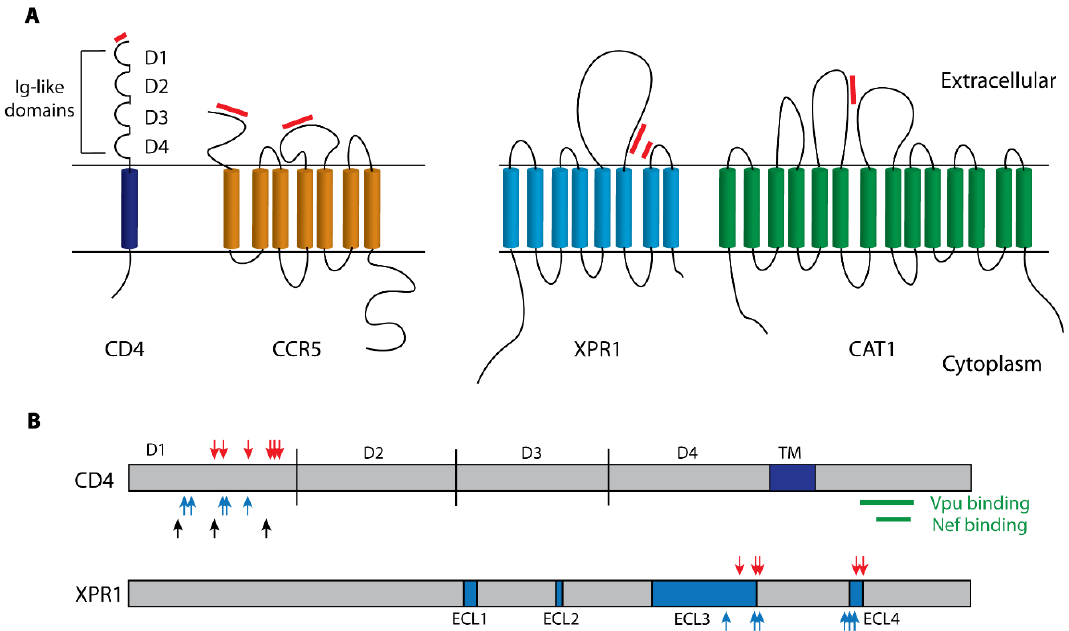
Figure 2. Structure and functional features of the HIV-1 and MLV cell surface receptors. ( A ) Schematic diagrams of the receptors for HIV-1 (CD4 and CCR5) and for different MLV subtypes (XPR1 and CAT1). Red bars indicate regions that bind virus envelope [7,16,17]. ( B ) XPR1 and CD4 receptor proteins. Blocks identify the transmembrane domain of CD4 and the extracellular loops (ECLs) in XPR1. Positively selected residues are marked with red arrows [13,17–19]. Receptor critical sites are marked with blue arrows and black arrows identify polymorphic sites in chimpanzee CD4 that influence SIV binding. Green bars identify CD4 sites susceptible to downregulation by Nef and Vpu [8,9,11,12].